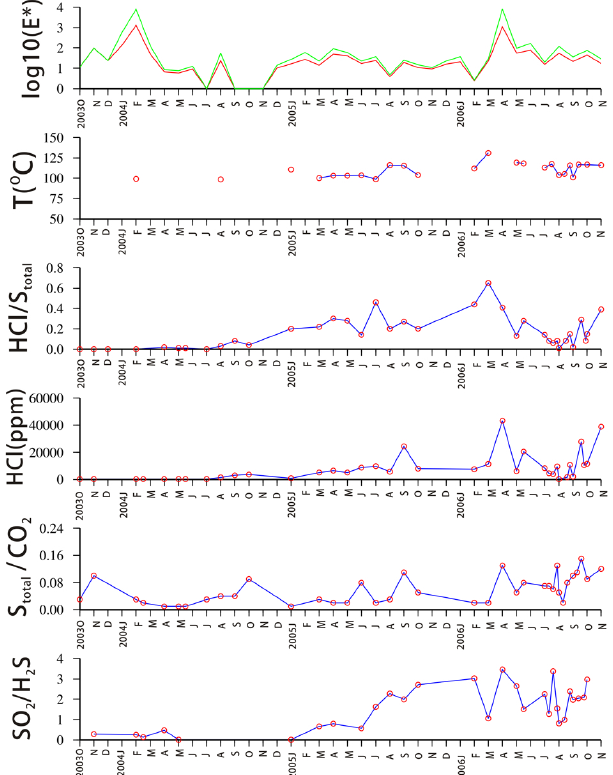
Fig. 10. Temporal variation of geochemical parameters and temper- ature readings of TVG fumarole gases for the period October 2003– November 2006 (after Lee et al., 2008). The top diagram represents the logarithm of calculated normalized seismic energy variations for the same time period using d = 1.5 (green line) and d = 1.96 (red line) (see text for more